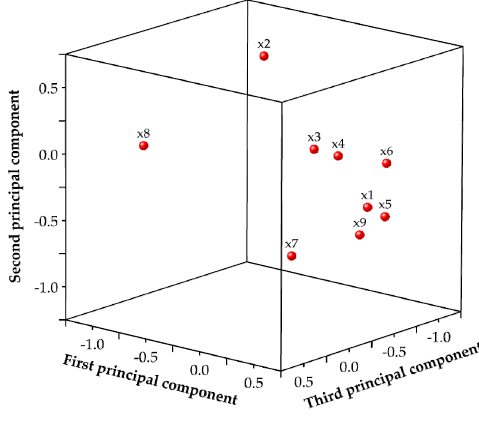
Figure 3. Loading diagram.